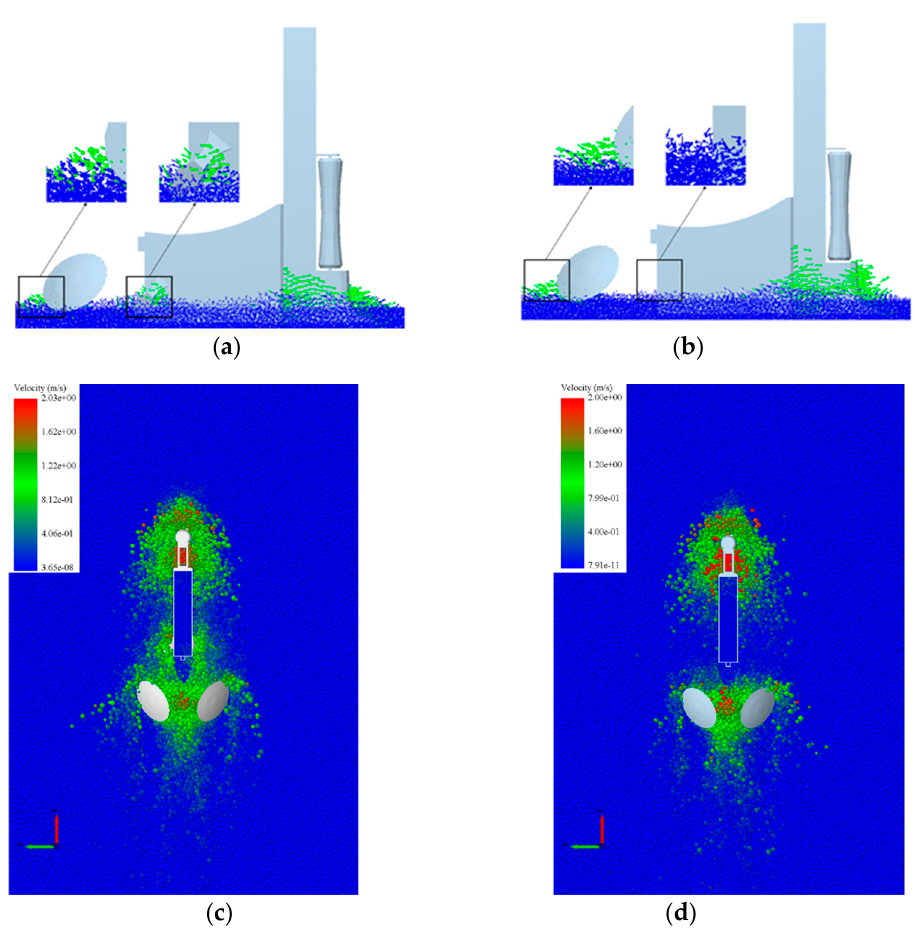
Figure 9. Comparison map of vector distribution of soil particle velocity: ( a ) Side view of the soil ‐ covering device with soil ‐ closing function from; ( b ) Side view of the Traditional double ‐ disc soil ‐ covering device; ( c ) Top view of the soil ‐ covering device with soil ‐ closing function from quarter view; ( d ) Top view of the traditional double disc soil ‐ covering device.